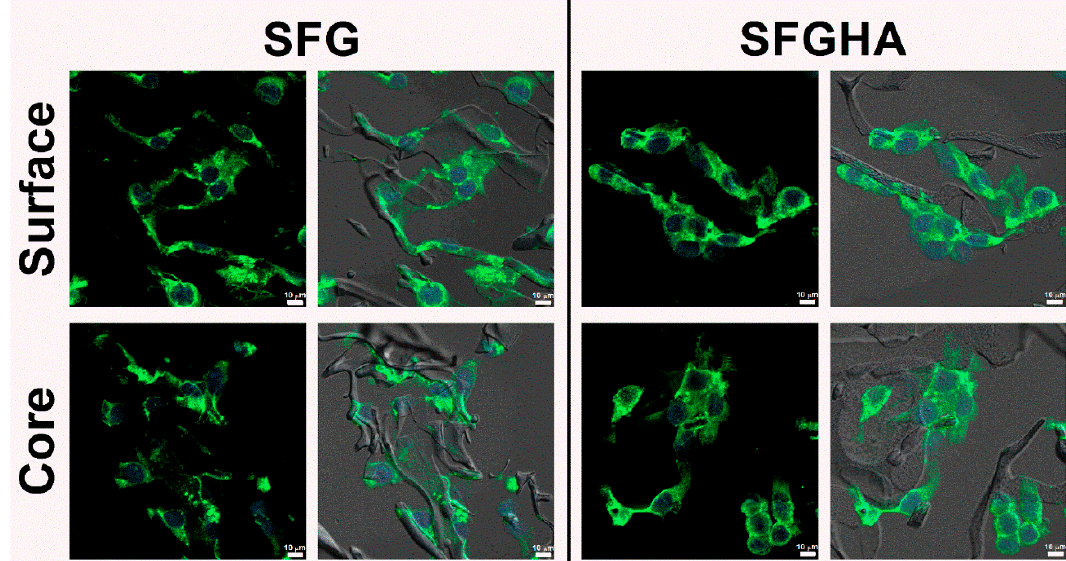
Figure 6. Immunohistochemical stained images of NIH/3T3-loaded scaffolds obtained after 5 days of seeding. Fluorescence images are aligned with the combined images of the bright-field and the stained images. Green and blue stains indicate the cytoplasm and nucleus, respectively. The images obtained from the scaffolds at the surface and core are shown. Scale bar = 10 µm.